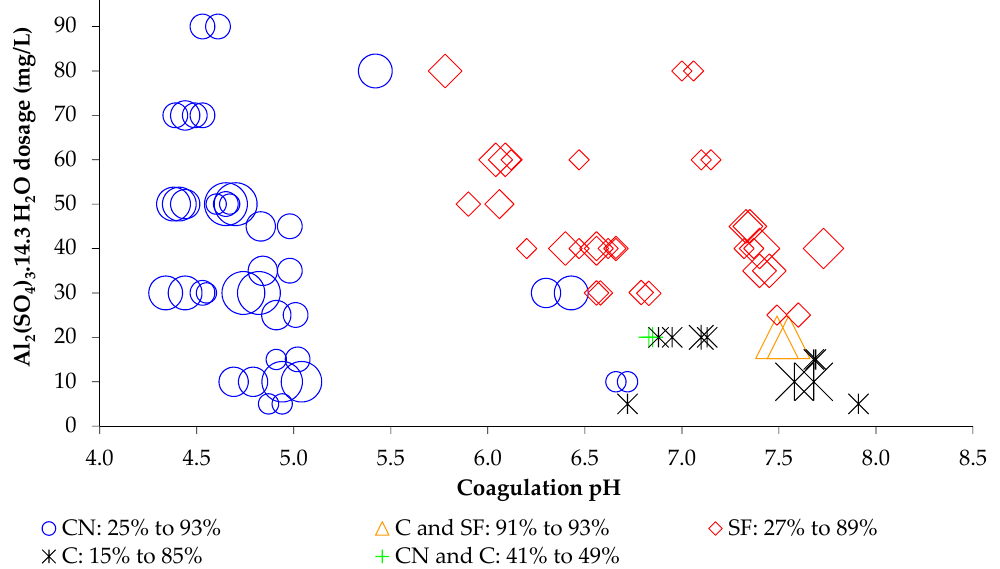
Figure 5. Coagulation diagram with turbidity removal points in relation to coagulation pH and dosage of aluminium sulfate in Type I, II, II and IV water samples—Conventional Jar Test.